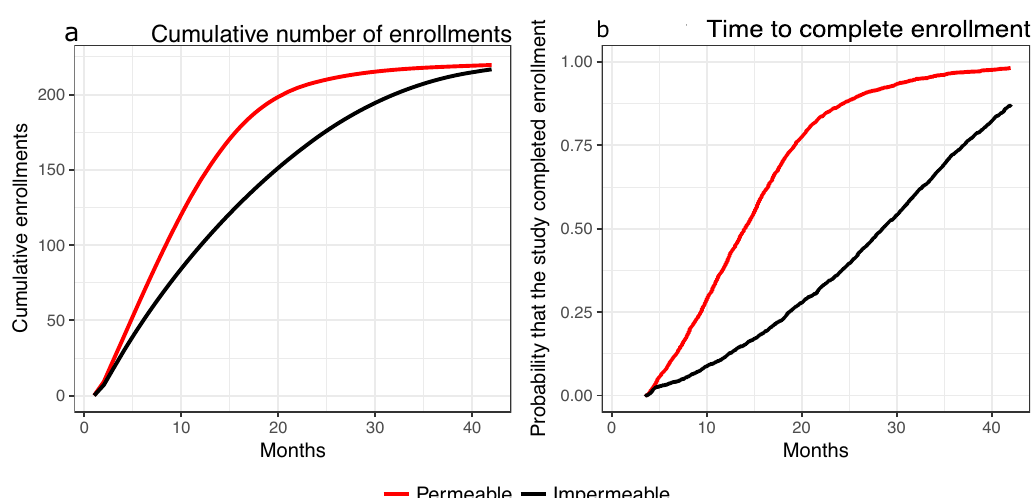
Fig. 2 Enrollment time in permeable and impermeable environments. The average cumulative number of enrollments ( a ) in permeable and impermeable environments and the distribution of the time to complete enrollment ( b ) for the fi rst study that evaluates an effective